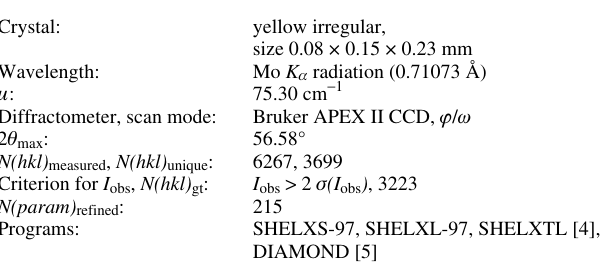
Table 1. Data collection and handling.